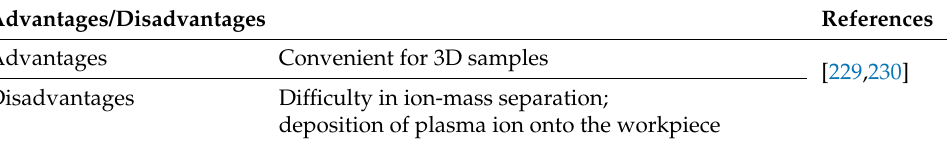
Table 17. Some of the significant advantages and disadvantages of plasma immersion ion deposition are mentioned in this